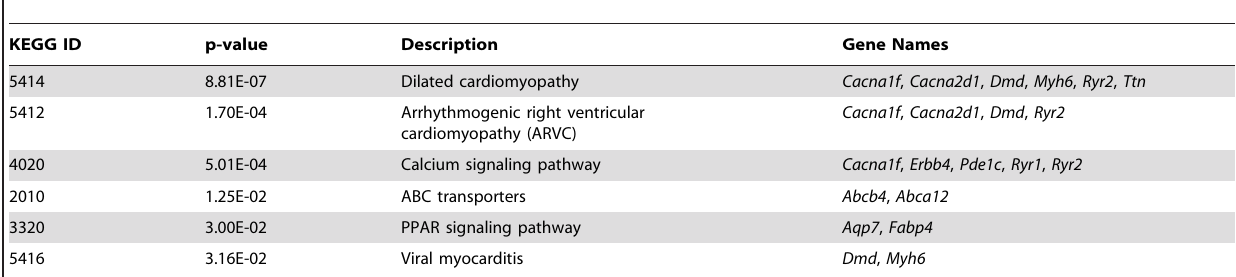
Table 5. Lung pathways